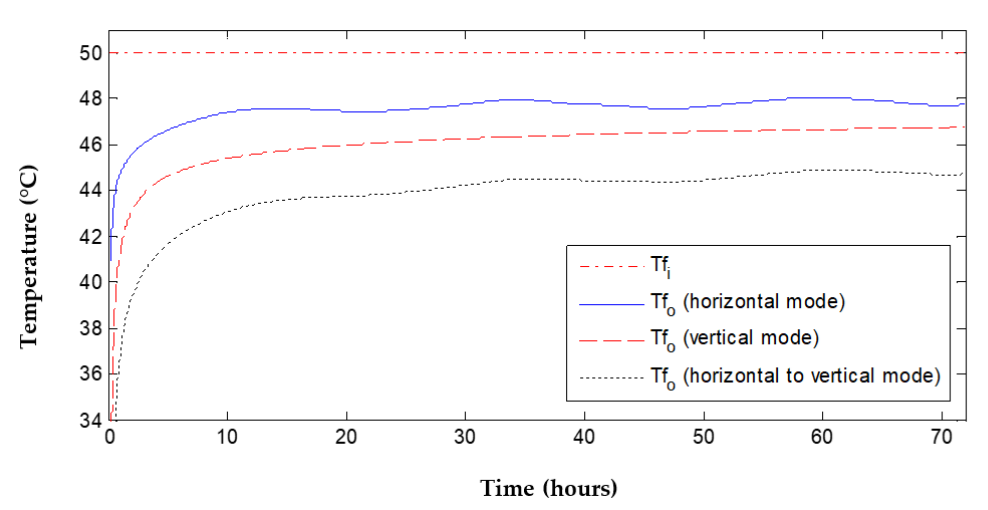
Figure 9. Profile of fluid temperature of the horizontal, vertical, and horizontal to the vertical mode in Adelaide.